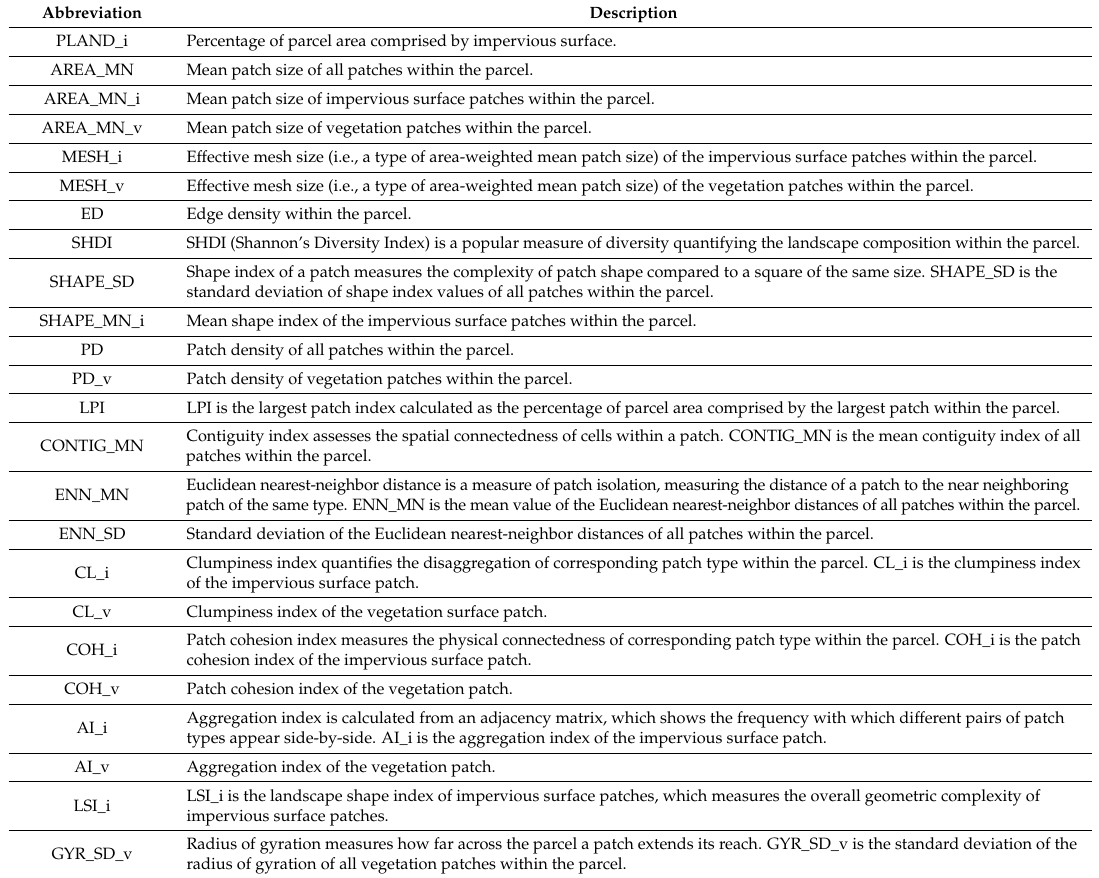
Table 2. Landscape metrics used in the urban land use classification